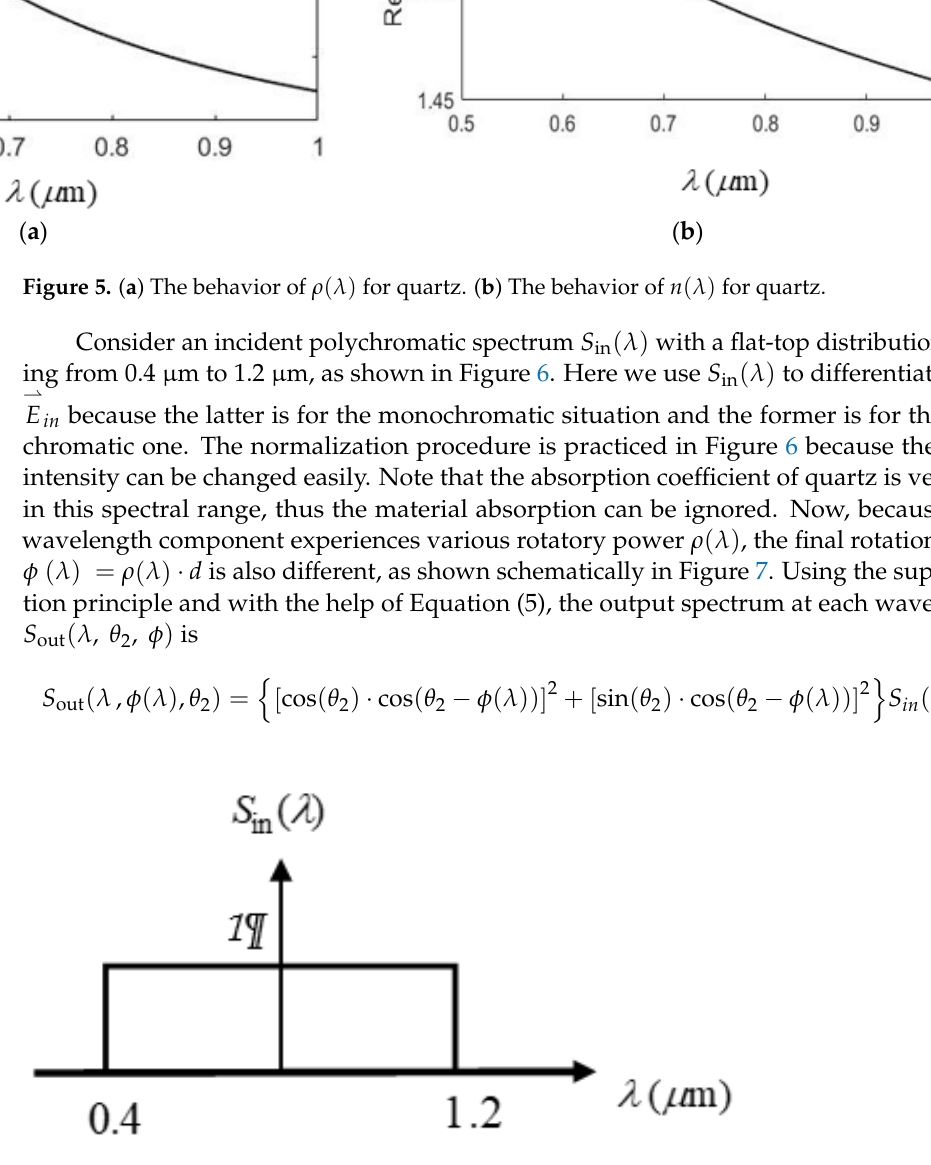
Figure 5. ( a ) The behavior of ( )  for quartz. ( b ) The behavior of ( ) n  for quartz.